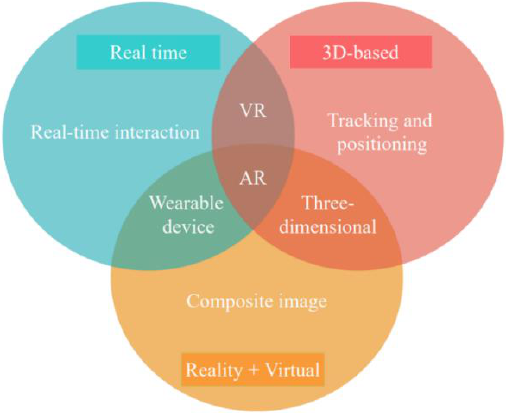
Figure 1. Three elements of AR summarized from the studies of Azuma [3].